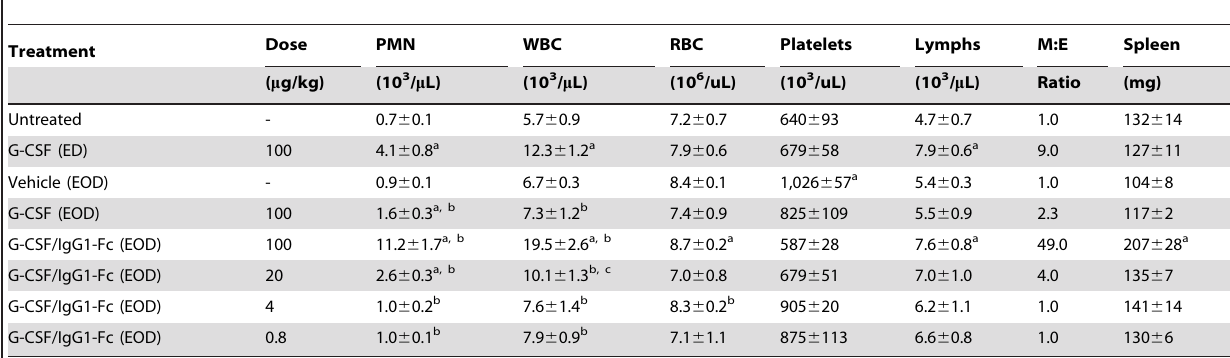
Table 2. Effect of every other day (days 1, 3 and 5) dosing of G-CSF and G-CSF/IgG1-FcL on day 6 blood cell counts in mice.